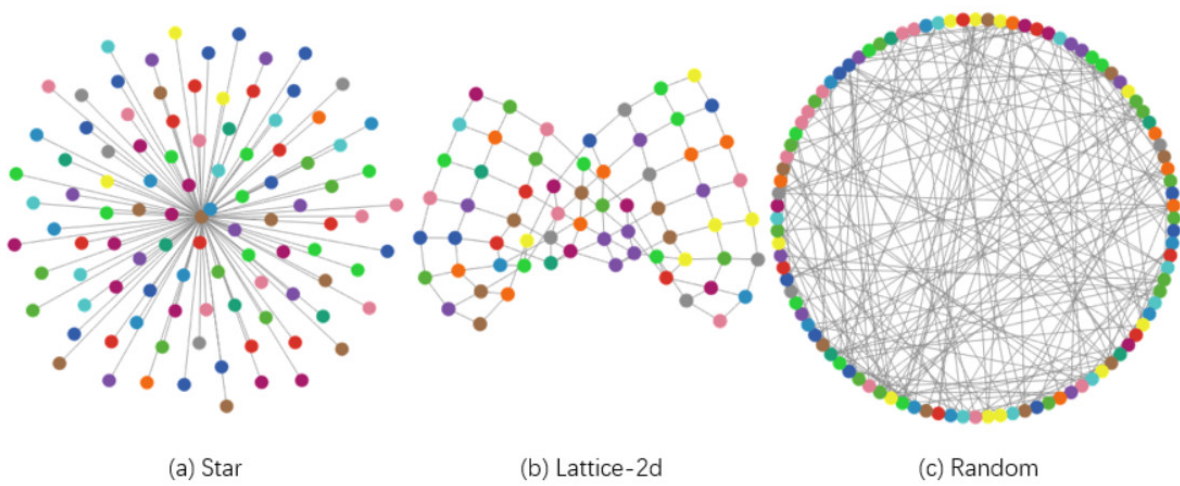
Figure 2. View of network topologies.